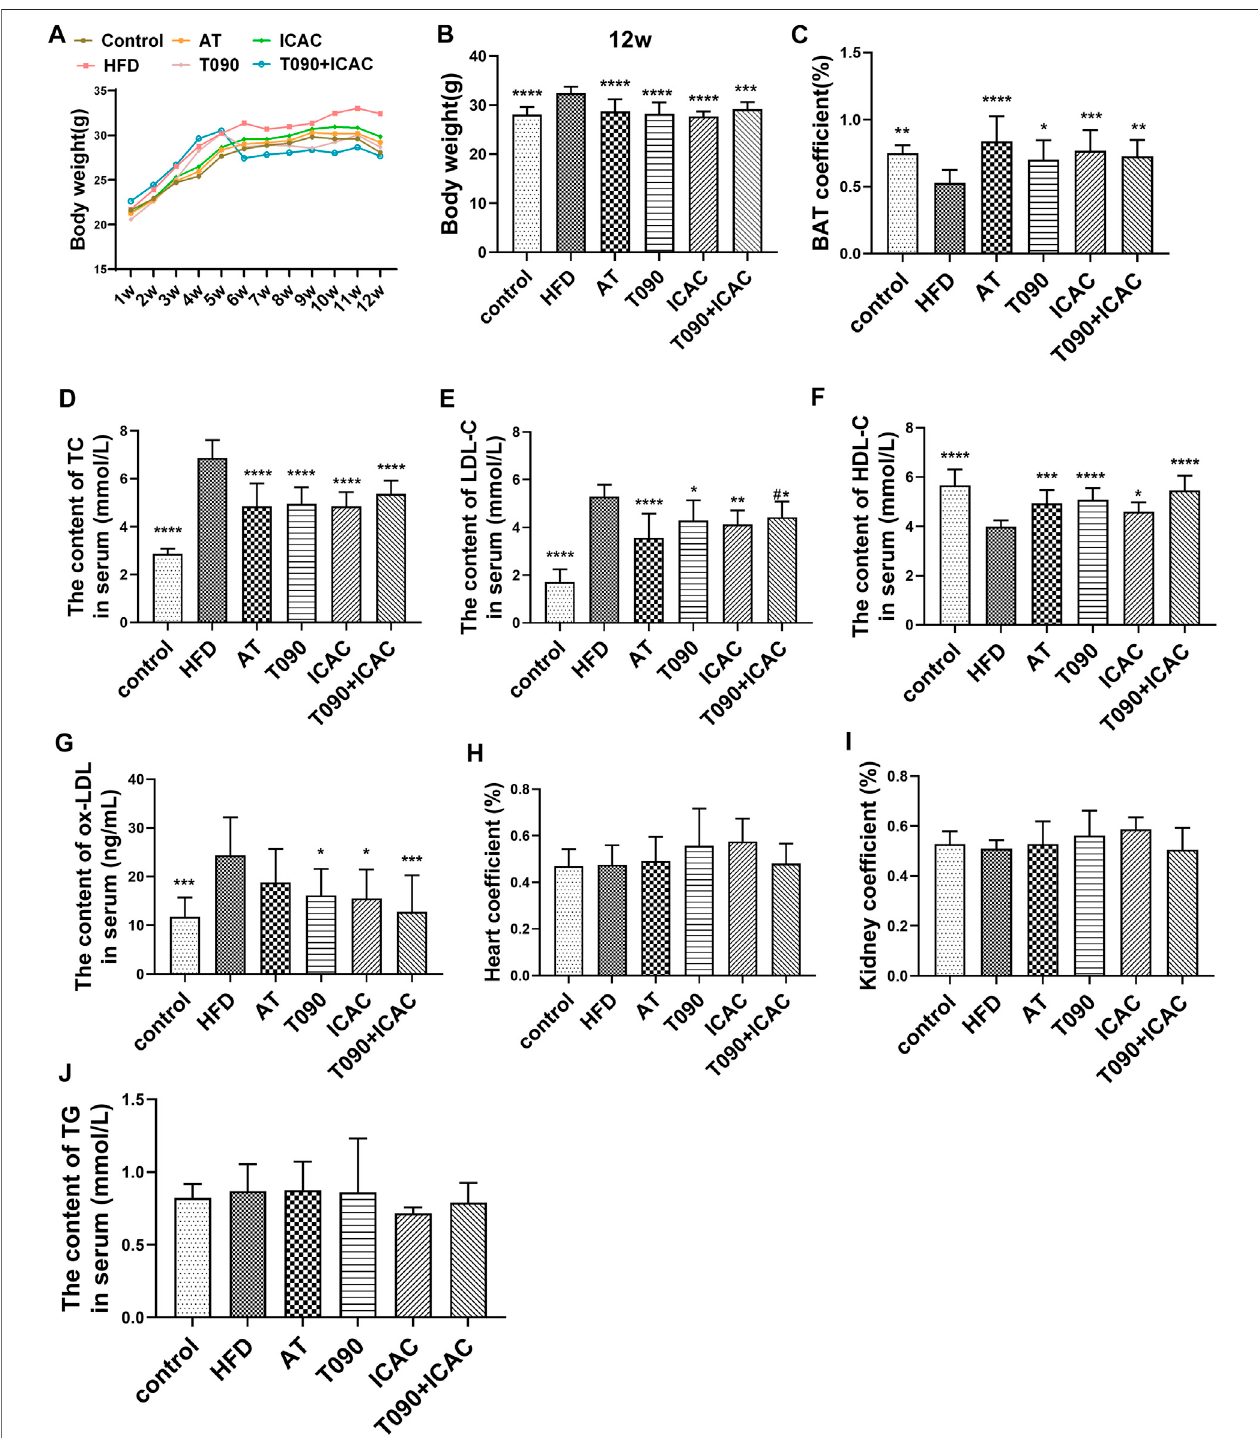
FIGURE 3 | ICAC decreases serum cholesterol and increases bile acid levels in hyperlipidemic mice. (A) Weekly weight of mice in each group. (B) Weight of each group in the 12-week. (C) Coef fi cients of brown adipose tissue. (D – G) Serum TC, LDL-C, HDL-C, ox-LDL of C57BL/6 mice fed a chow diet or a high fat diet with or without T0901317 or icac for 12 weeks. (H,I) Coef fi cients of the heart and kidney. (J) Serum TG levels of all groups at the end of treatment. All data were represented mean±SEM.Statisticaldifferencewasdeterminedbyone-wayANOVAtest.ComparewithHFD,* p < 0.05,** p < 0.01,*** p < 0.001,**** p < 0.0001. n =10foreach group. Compared with AT, # p <